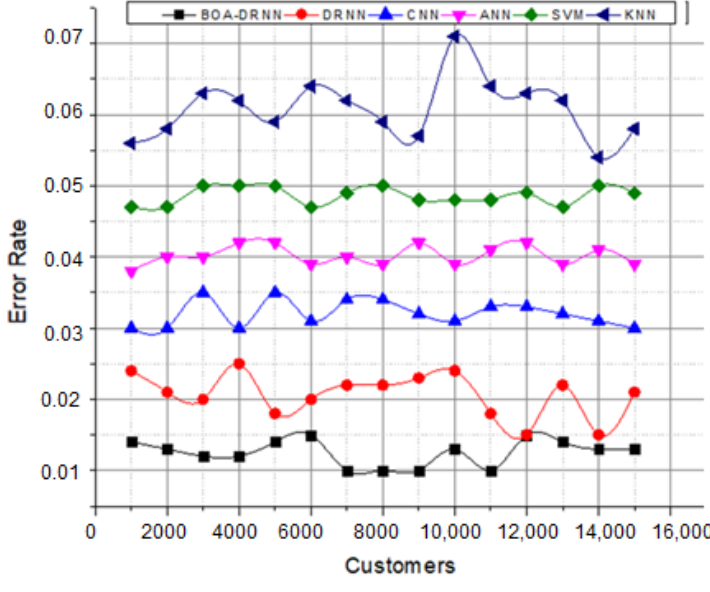
Figure 6. Error Figure 6. Error rate.